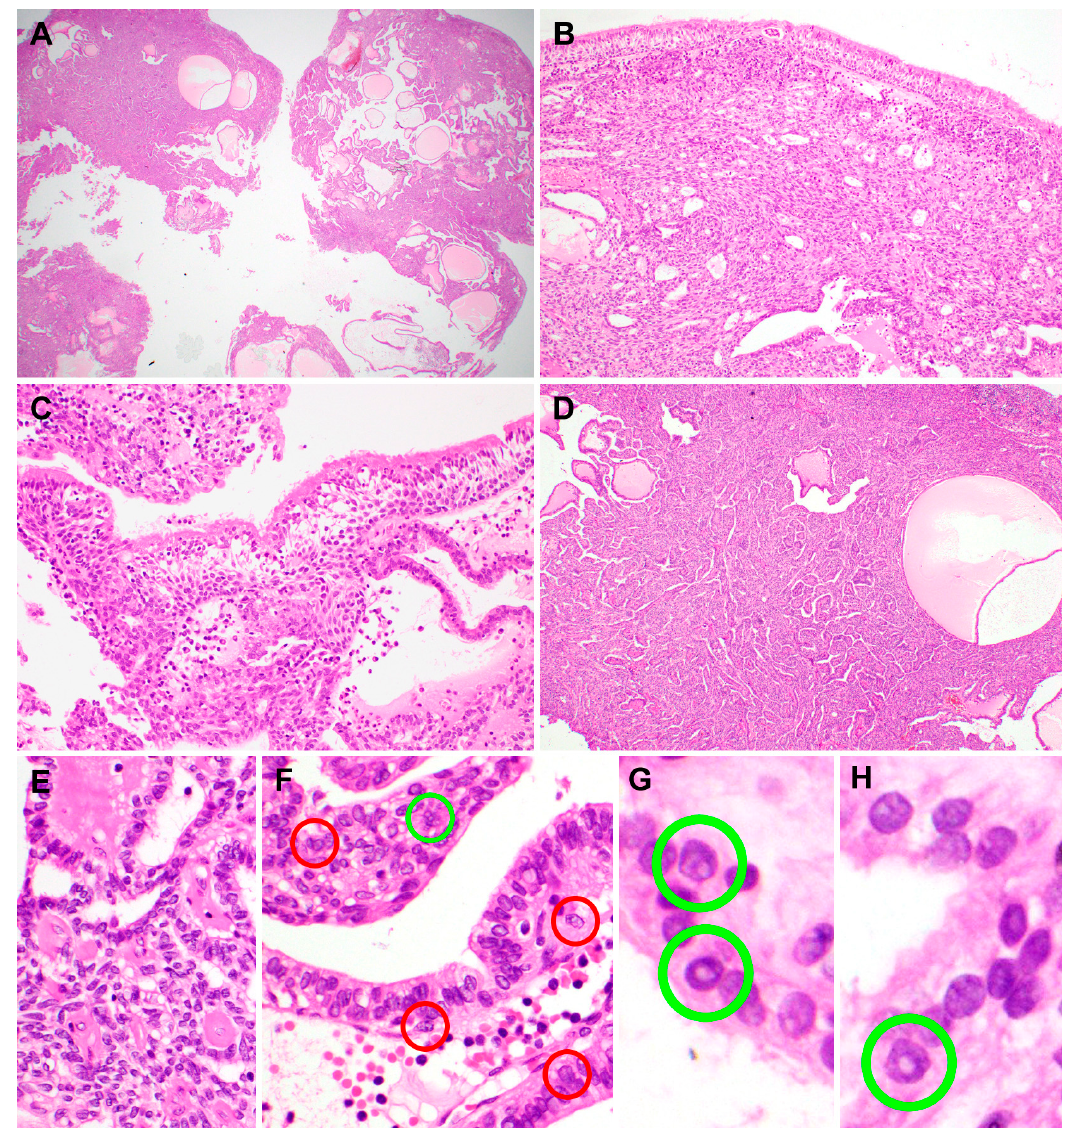
Figure 2. Histopathological features of the papillary component of biphasic thyroid-like low-grade nasopharyngeal papillary adenocarcinoma. ( A ) On a scan view, the tumor was solid and cystic, without necrosis or hemorrhage. Several scattered microcysts contained colloid-like, amorphous eosinophilic material. ( B ) The tumor was covered with an unremarkable surface epithelium. ( C ) Tumor cells merged with normal respiratory epithelium. ( D ) The papillary component showed complex, tightly packed papillary tufts. Slit-like spaces between papillae were even throughout the papillary component. ( E ) Some fibrovascular cores were hyalinized (left half). ( F ) Epithelial cells covering the papillae exhibited nuclear abnormalities resembling those of papillary thyroid carcinoma, such as nuclear membrane irregularity (red circles), intranuclear pseudoinclusions (green circles), and a ground-glass appearance. ( G and H ) High-power magnification view of the nuclear morphology; green circles indicate those resembling papillary thyroid carcinoma. Hematoxylin and eosin stain. Original magnification: A, 12.5×; B, 60×; C, 100×; D, 40×; E and F, 200×; G and H, 400×.